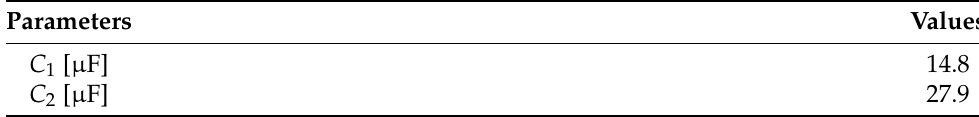
Table 4. Parameters of the ladder circuit in the classic case model.